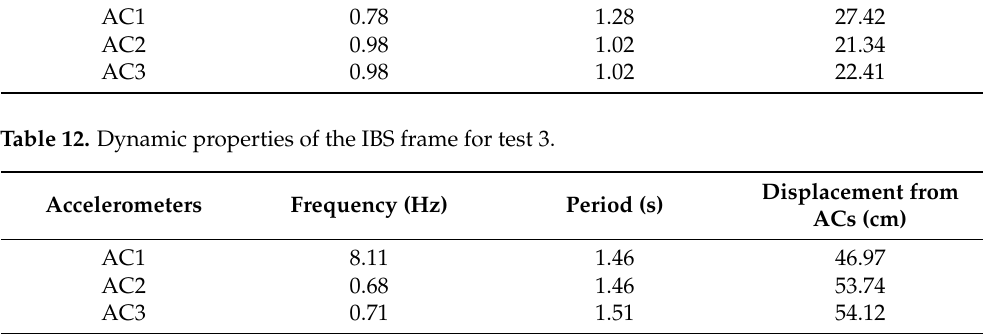
Table 12. Dynamic properties of the IBS frame for test 3.